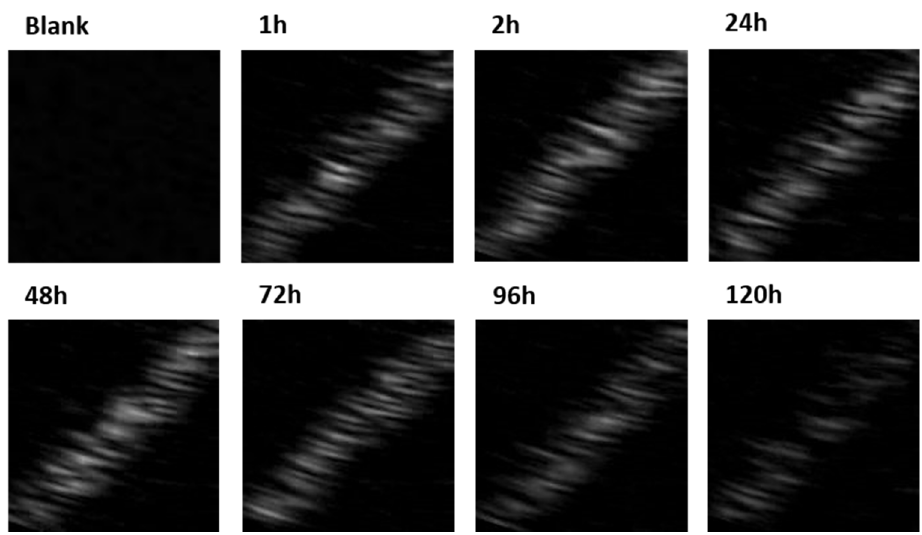
Figure 4. Representative images US contrast of PFP loaded Lip-MSNPs at different time intervals with 3.5 MHz and MI 0.7.